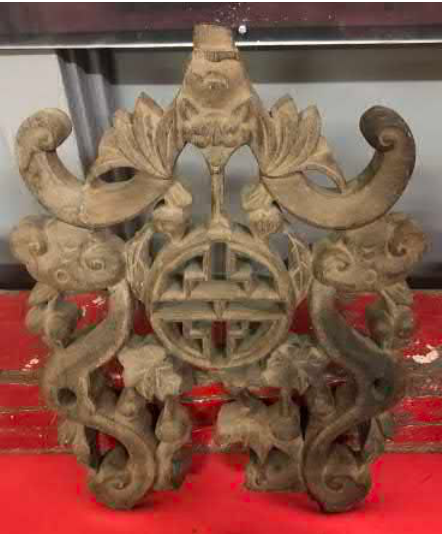
Figure 5: Lucky bat, NT Chinese Temple and Museum, Darwin. (Photo: Anna Halafoff)